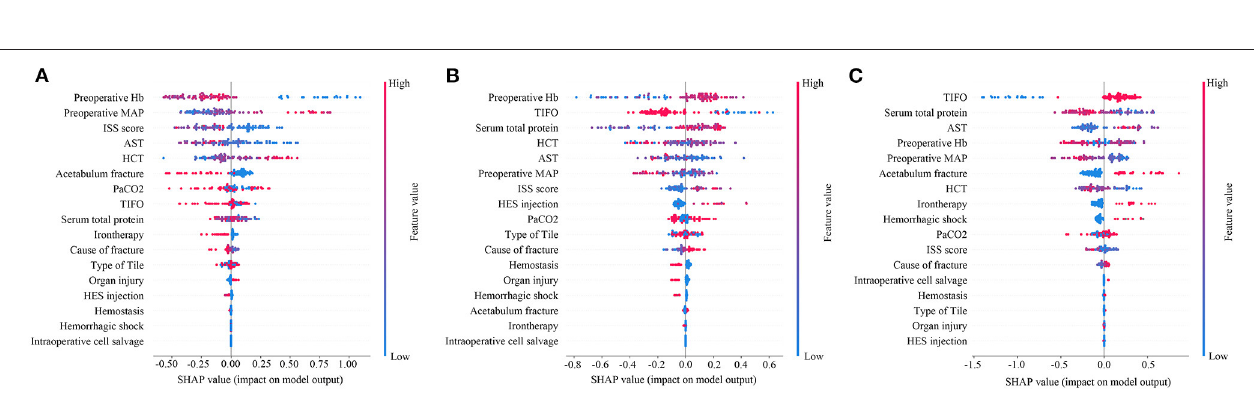
FIGURE 4 | Feature importance plot for the (A) machine learning predictive model whether RBCs transfusion or not; (B) machine learning model to predict whether less RBCs transfusion ( < 4U) or not and (C) machine learning model to predict whether more RBCs transfusion ( ≥ 4U) or not. The blue and red points in each row represent participants having low to high values of the specific variable, while the x-axis gives the SHAP value, which gives the impact on the model. SHAP, Shapley Additive Explanation values; MAP, preoperative mean arterial pressure; TIFO, time from the injury and the first operation; AST, aspartate transaminase; HCT, hematocrit; ISS, injury severe score; PaCO 2 , partial pressure of carbon dioxide; HES, hydroxyethyl starch.